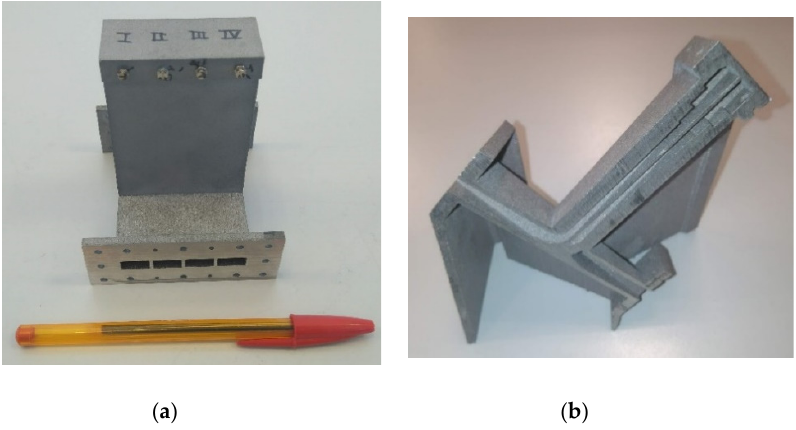
Figure 6. Photographs of the reconfigurable phase-shifters block built using DMLS: ( a ) frontal view; ( b ) cut view that allows observing the internal parts of the device.